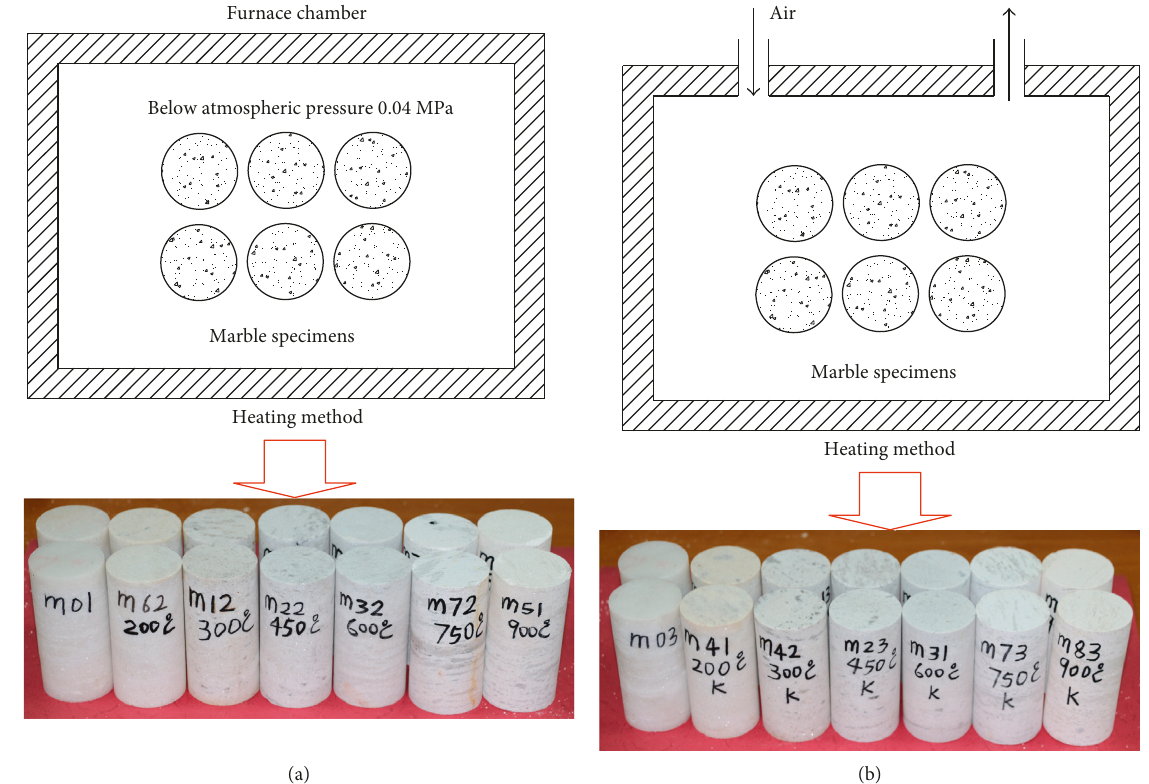
Figure 1: Heating method and the prepared marble specimens after heat treatment. (a) Vacuum environment. (b) Airiness